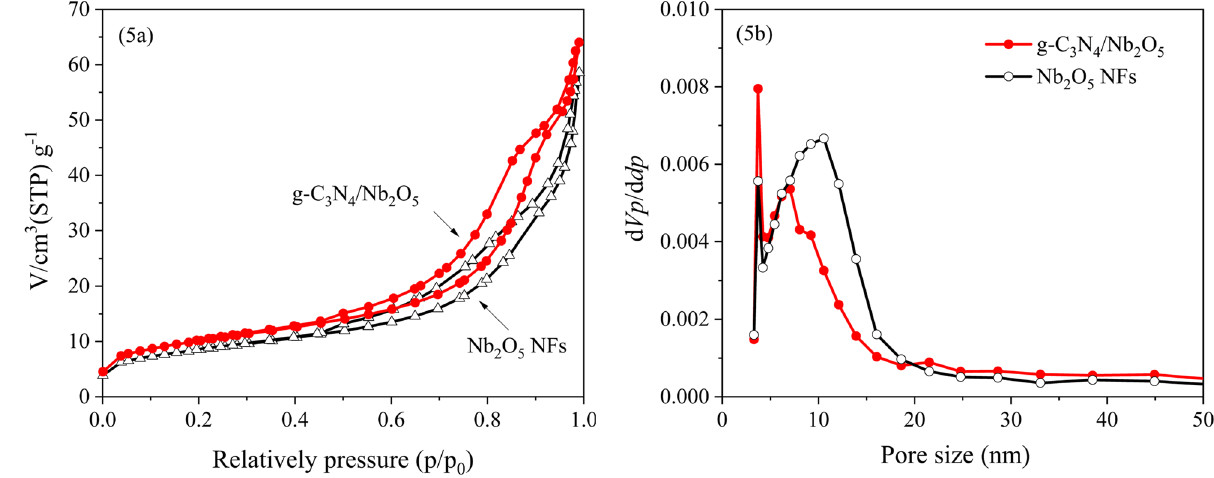
Figure 5. ( a ) N 2 sorption isotherm and ( b ) pore size distribution of Nb 2 O 5 NFs and g-C 3 N 4 /Nb 2 O 5 heterojunction.